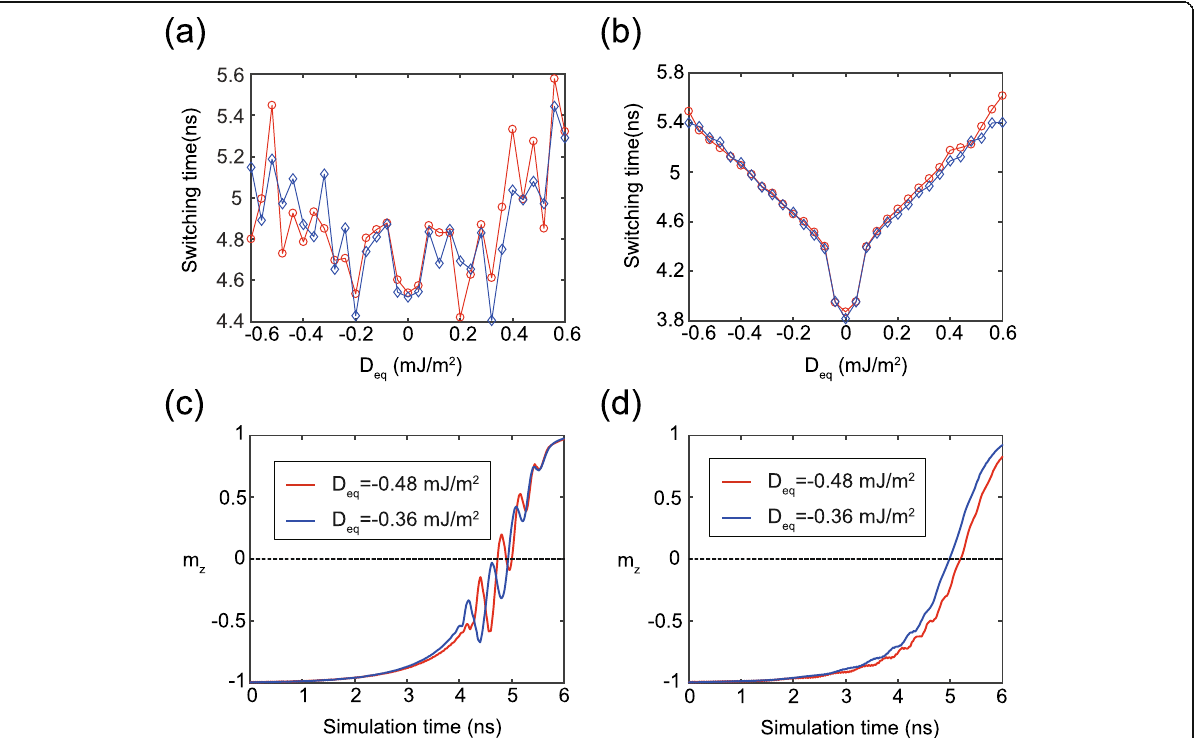
Fig. 4 a , b Switching time as a function of D eq . Each D eq is obtained with two pairs of different { D 1 , D 2 } values according to D eq = ( t 1 D 1 + t 2 D 2 )/ ( t 1 + t 2 ). Red curve: D 1 is varied meanwhile D 2 is fixed to 1 mJ/m 2 . Blue curve: D 1 and D 2 are always set to the same value. Here σ = 1 × 10 − 2 J/m 2 . In a , the other parameters are configured as Table 1. In b , K u 1 = K u 2 = 0.7 mJ/m 3 for an ideal case. c , d Typical results of time-dependent m z corresponding to a and b ,